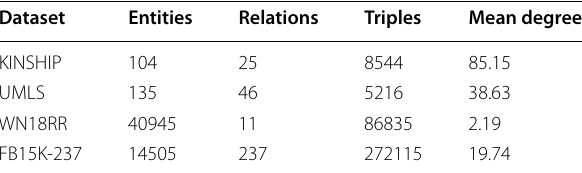
Evaluation Criteria